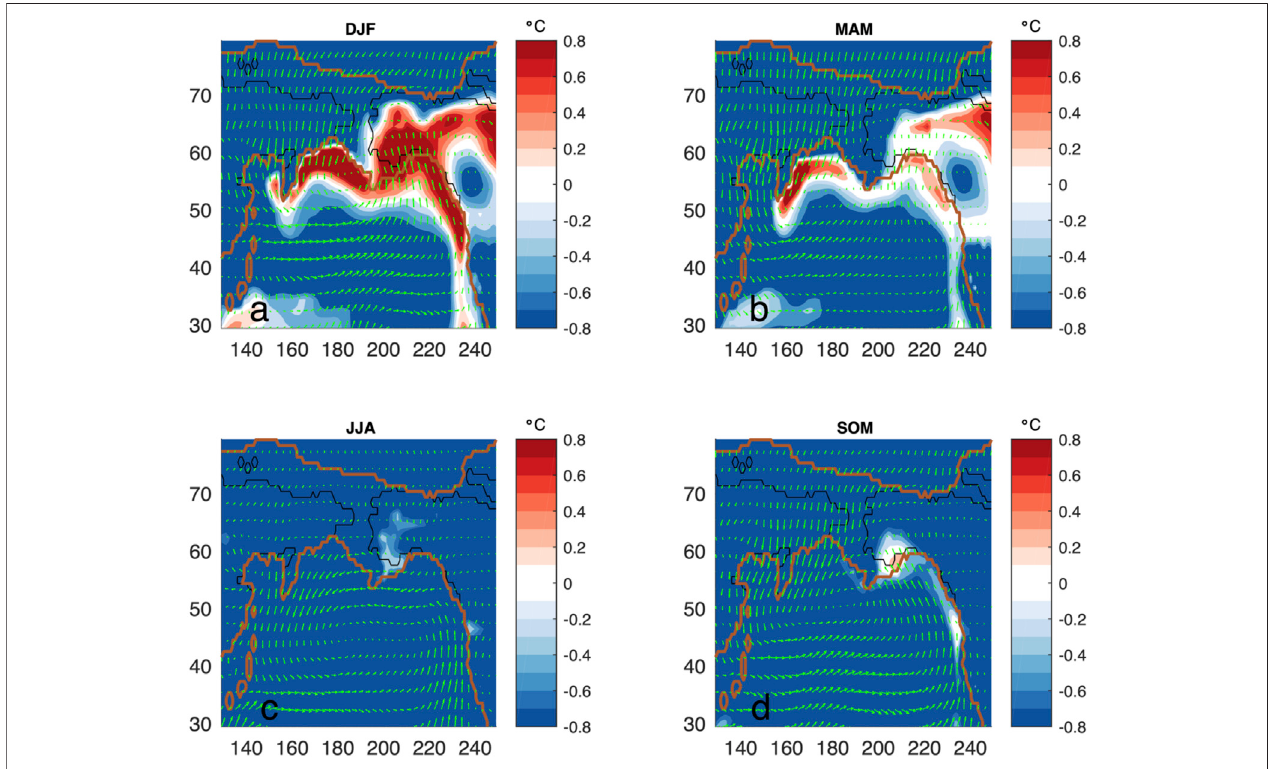
FIGURE6| ModelledseasonalsurfaceairtemperaturesandwindanomaliesoftheHS1relativetotheLGMconditions(meanover100 years).a-dshowtheboreal winter (DJF), spring (MAM), summer (JJA) and autumn season anomalies, respectively. The black and brown lines describe the modern and LGM coast lines.